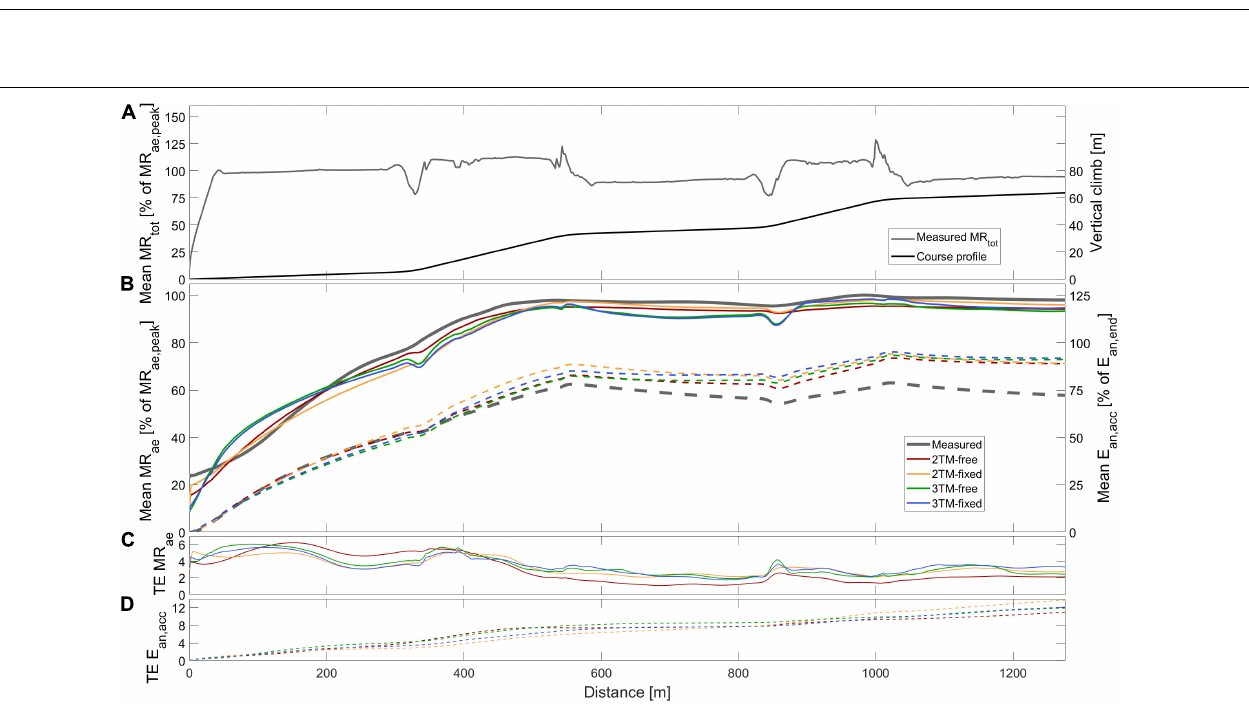
Frontiers in Physiology | www.frontiersin.org